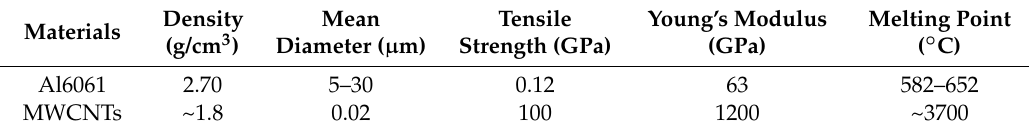
Table 1. Properties of Al6061 alloy and multi-walled carbon nanotubes